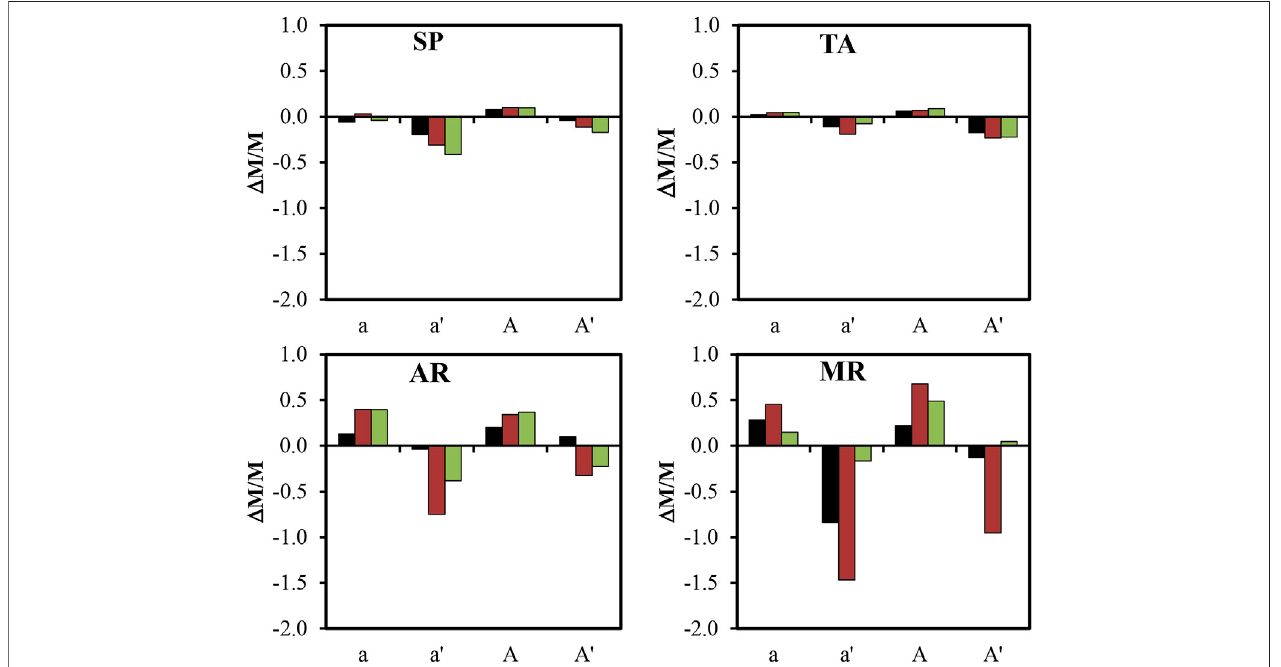
FIGURE 6 | Difference in weight ( Δ M/M, in %) of the four varieties of rock depending on the saw-cut (S), honed (H) and bush-hammered (BH) fi nishes exposed to Solution A of the non-consolidated (a and a ′ ) and consolidated (A and A ′ ) samples. Legend: SP, Calcarenita de Santa Pudia; TA, Travertino Amarillo; AR, Arenisca Ronda; MR, Molinaza Roja; a and a ′ , Difference in weight between the altered samples before and after removal of the gypsum crust compared to the fresh samples, respectively; A and A ′ , Difference in weight between the altered samples before and after removal of the gypsum crust compared to the fresh and consolidated samples,